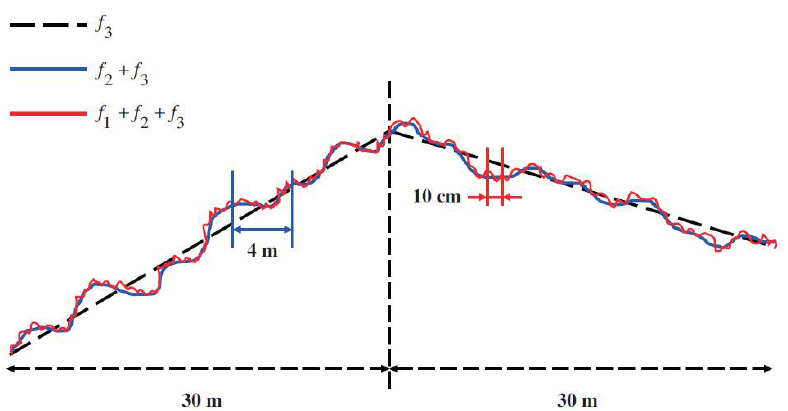
Figure 8. Profile of f = f 1 + f 2 + f 3 . f 1 : microwave roughness, f 2 : finescale topography, f 3 : planar from DEM. f 1 and f 2 are random, f 3 is